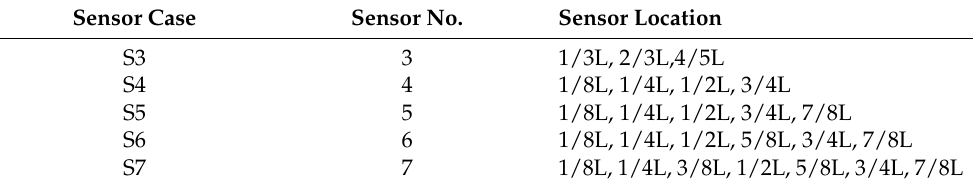
Table 3. Sensor Placement.